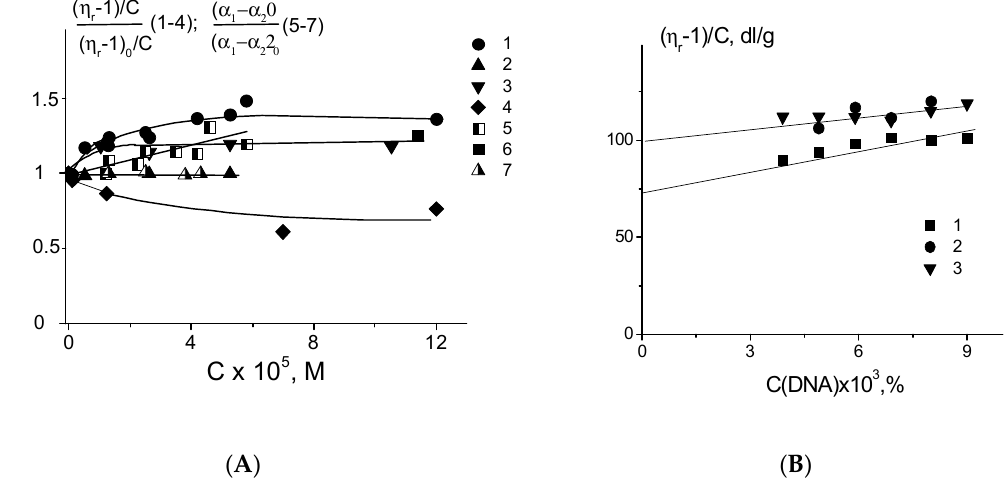
Figure 4. Relative change in reduced viscosity of DNA solutions (1–4) and optical anisotropy of DNA statistical segment (5, 6, 7) with increasing concentration of Ag–Phen (1, 5), AgNO 3 (2, 7), Phen (3), and Ag–Phen with the addition of NaBH 4 (4, 6) in 0.005 М of NaNO 3 . ( A ); dependence of reduced viscosity of DNA solutions in 0.005 M NaCl on C (DNA) (3) and the result of different dilution of the stock solution containing DNA complexes with Ag–Phen prepared at С (Ag–Phen) = 2 × 10 − 5 M and С (DNA) = 0.009%, in 0.005 M NaNO 3 , using 0.005 M NaNO 3 (1) and С (Ag–Phen) = 2 × 10 − 5 M in 0.005 M NaNO 3 (2) as a diluent ( B ).